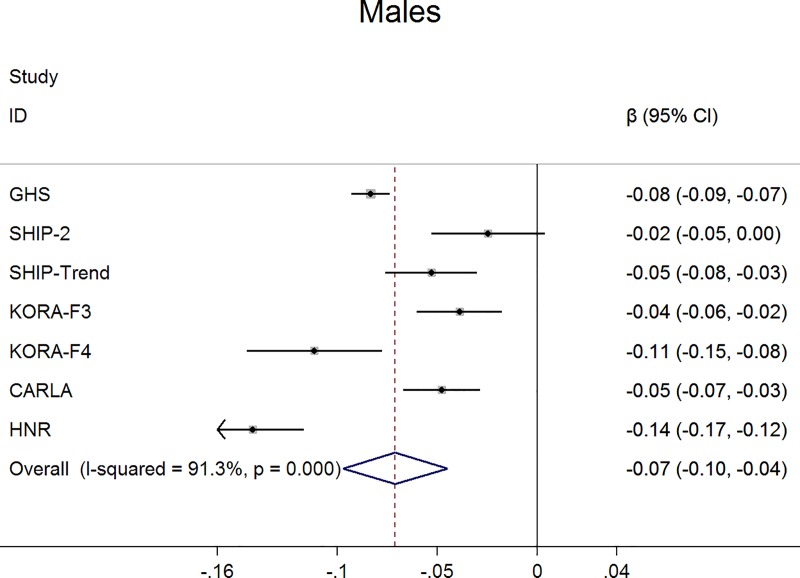
Association between claudication (definition 1) and ABI in men.